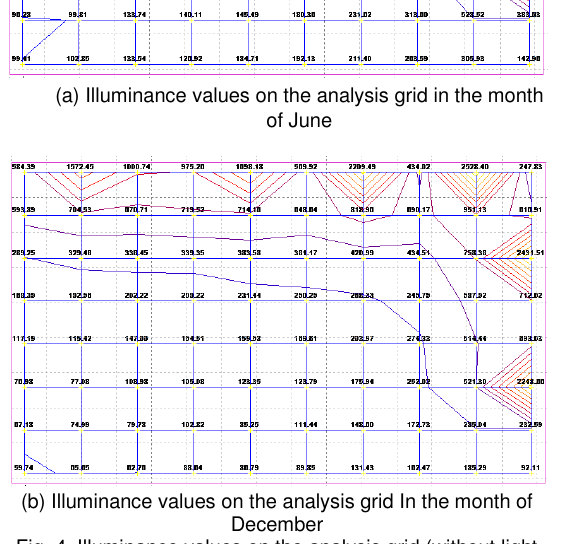
Fig. 4. Illuminance values on the analysis grid (without light Shelves) Table 4. Average illuminance